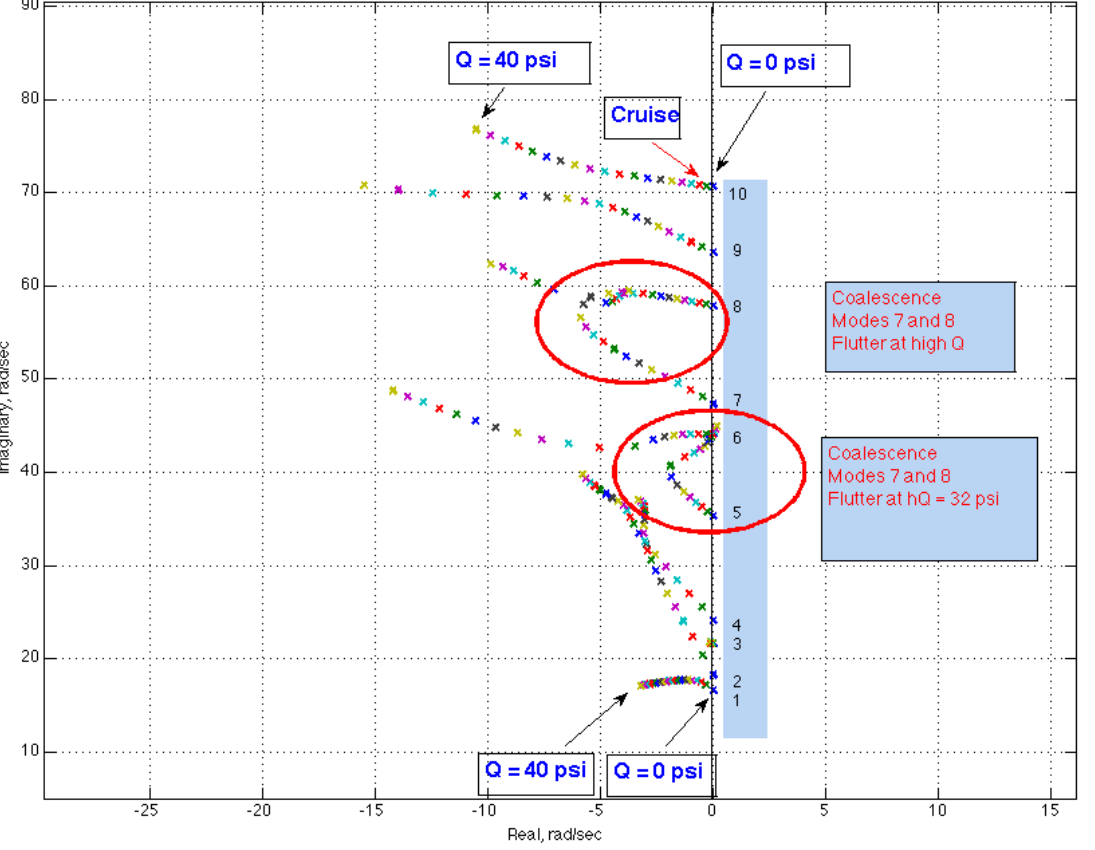
Figure 9. Aeroelastic root locus plot for the low-boom N+2 configuration at M = 1.7 with each colored marker indicating an increment of 2 psi in dynamic pressure for a given